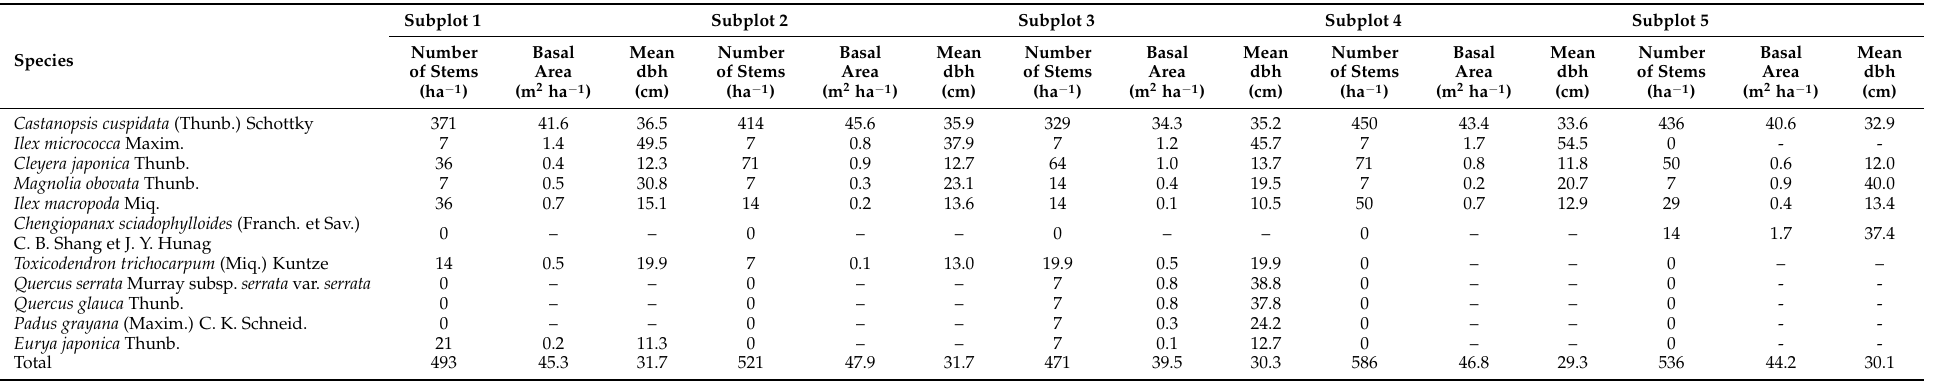
Table 2. Floristic composition (dbh ≥ 10 cm) and forest structures in each subplot (1400 m 2 ) in the lucidophyllous forest at the end of the study period (February